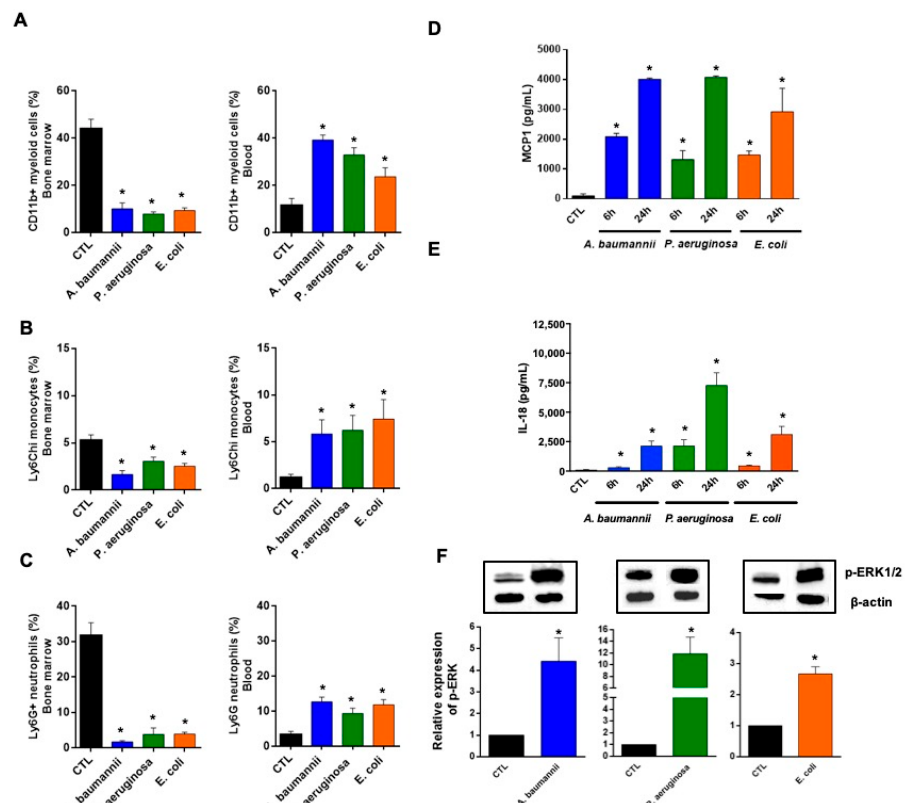
Figure 1. Bone marrow immune cells’ migration to the blood in response to monocyte chemo- tactic protein-1 (MCP-1) and interleukin-18 (IL-18) during bacterial infection. ( A ) Myeloid cells, ( B ) inflammatory monocytes, and ( C ) neutrophils were identified as CD11b+, CD11b+Ly6C hi , and CD11b+Ly6G+, respectively, by flow cytometry in the bone marrow and blood of mice infected with MLD100 of A. baumannii ATCC17978, P. aeruginosa PAO1, or E. coli ATCC25922 strains for 24 h. ( D,E ) Serum MCP-1 and IL-18 levels (enzyme-linked immunosorbent assays (ELISAs)), 6 and 24 h post-infection, in mice infected with minimal lethal dose 100 (MLD100) of A. baumannii ATCC17978, P. aeruginosa PAO1, or E. coli ATCC25922 strains. ( F ) RAW 264.7 cells were infected with A. baumannii ATCC17978, P. aeruginosa PAO1, or E. coli ATCC25922 strains for 2 h and proteins were collected for phospho-p44/42 Mitogen-Activated Protein Kinases (extracellular signal-regulated kinase 1/2 (Erk1/2)) and β -actin immunoblotting. Data are representative of six mice per group, and expressed as mean ± standard error of the mean (SEM). * p < 0.05: infected vs. control (CTL). CTL: non-infected mice, %: the percentage of myeloid cells, inflammatory monocytes and neutrophils from total cells in bone marrow or